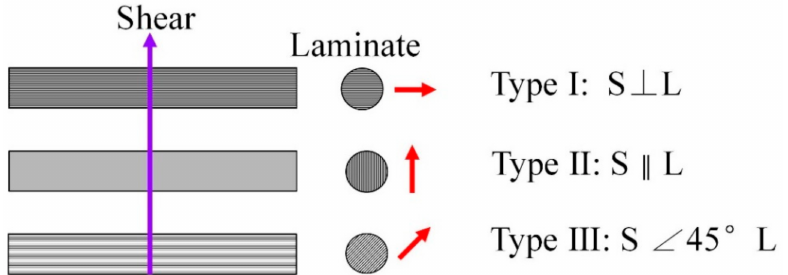
Figure 2. Schematic of three types of double-shear tests for the C/SiC pin.